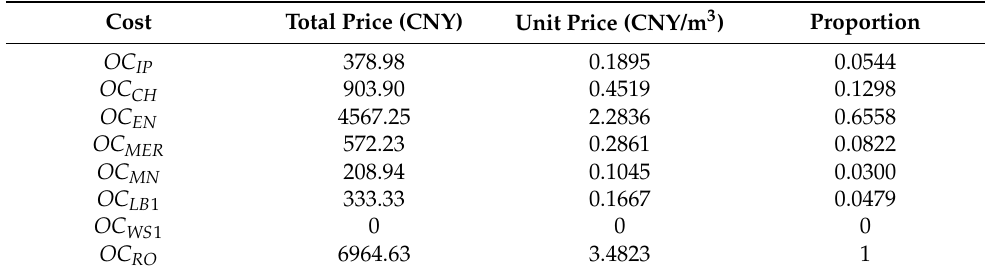
Table 20. SWRO system cost ratio